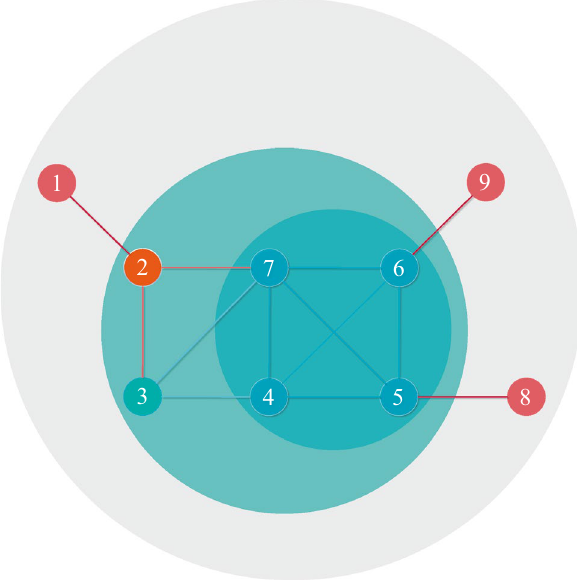
Figure 1. A toy network with nine nodes to illustrate the resolution limit problem for DC and KS.